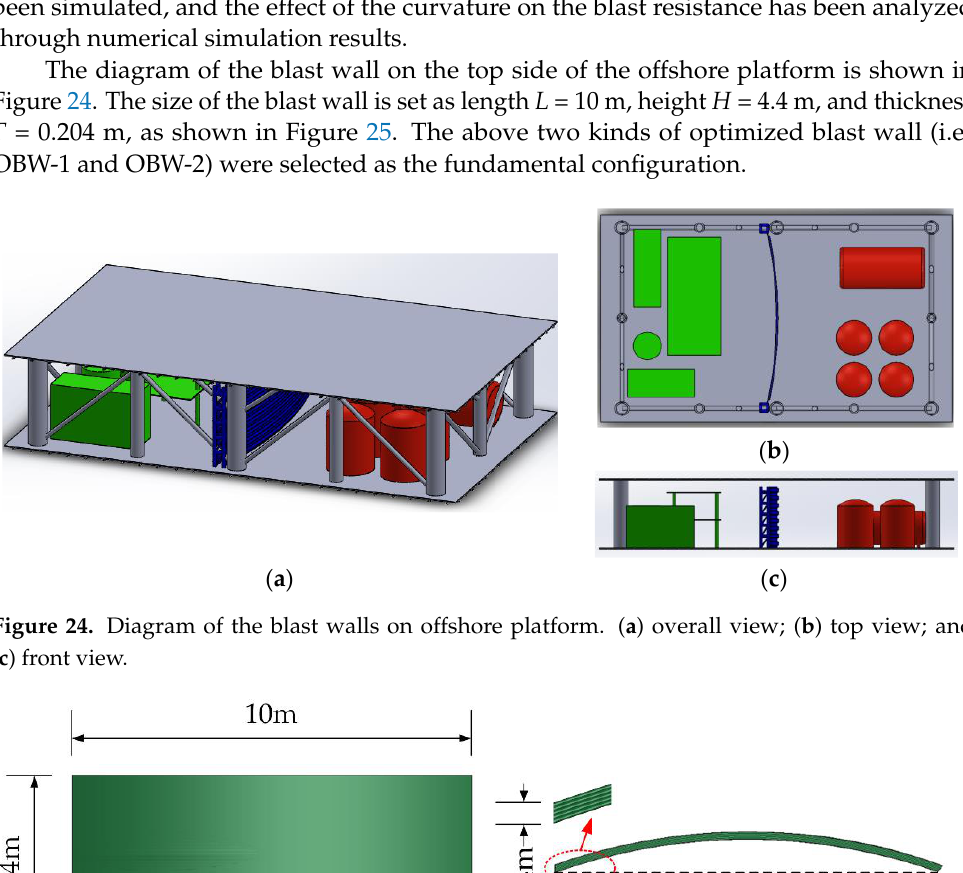
Figure 27. A fully clamped boundary condition was adopted around the curved blast wall.